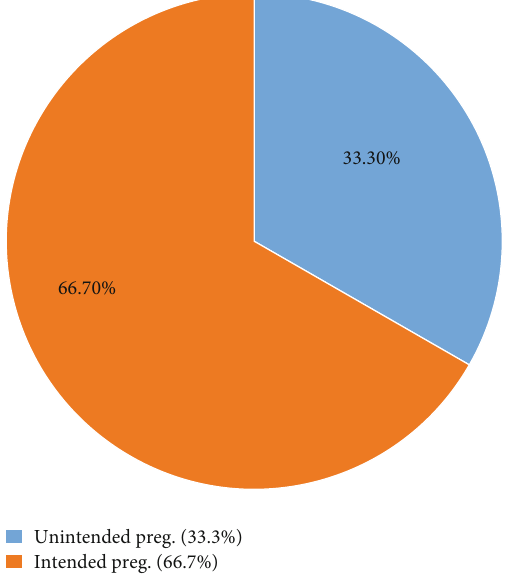
Figure 1: Magnitude of pregnancy among pregnant women attending ANC at Bako Tibe district, Ethiopia, 2019.